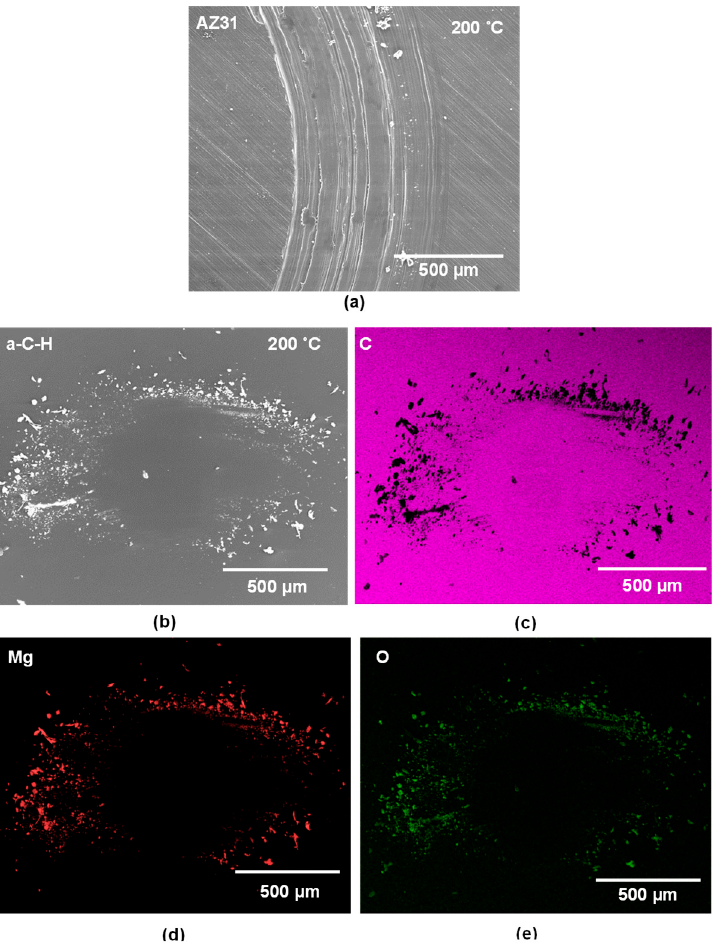
Figure 9. ( a ) Secondary electron image of the wear track developed on the contact surface of uncoated AZ31 when running against a-C-H at 200 °C; ( b ) Back scattered electron image of a-C-H ball surface tested against uncoated AZ31 at 200 °C; ( c – e ) The EDS elemental maps for ( c ) C, ( d ) Mg, and ( e ) O.